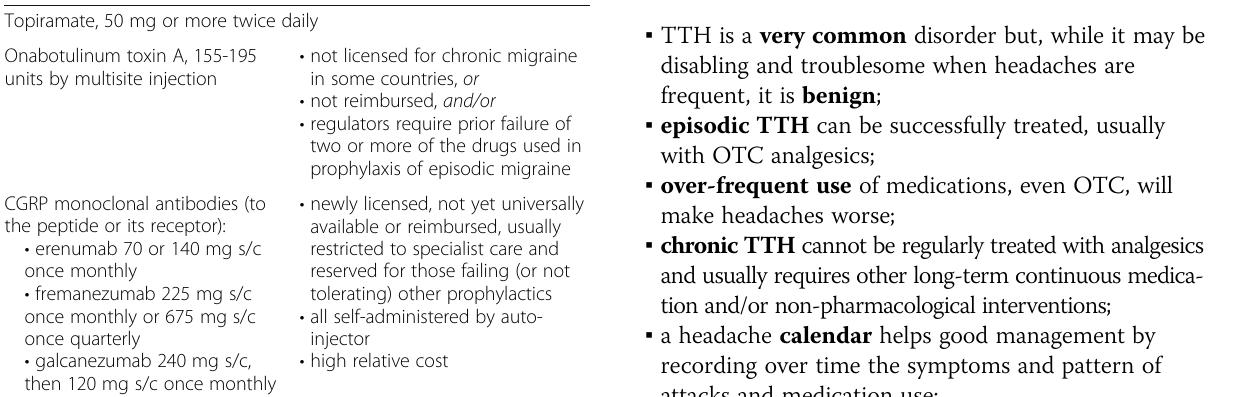
Table 10 Drugs used by specialists in chronic migraine